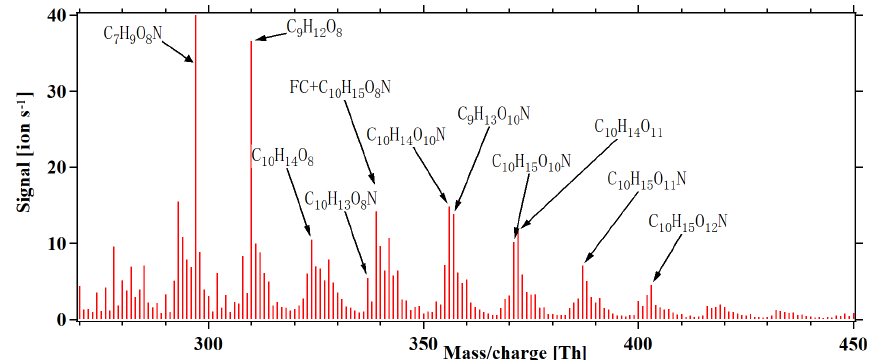
Figure 8. HOM mass spectrum during steady-state alpha-pinene oxidation in the presence of 10ppb NO x , with seven lights switched on. In addition to molecules detected also in the experiments without NO x , several abundant organic nitrate peaks are formed. Note that a fluorinated compound (FC) overlaps with the organic nitrate C 10 H 15 O 8 N at 339Th. All peaks are detected as clusters with NO − C 10 H 16 concentration is around 13.3 ppb without any